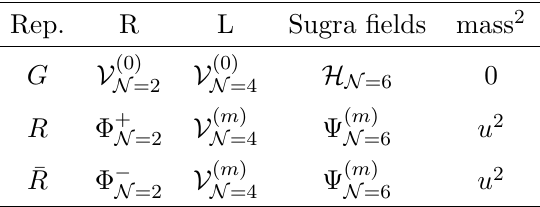
denote the two N =2